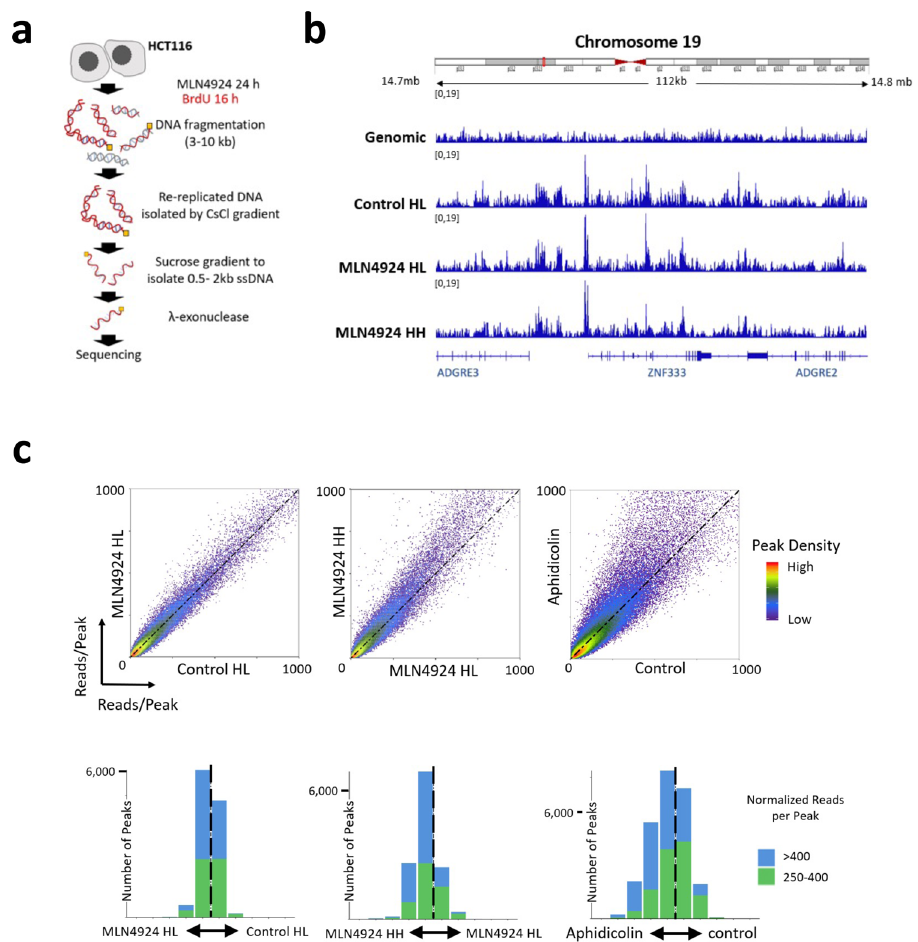
Fig. 3 Re-replication is driven by the same set of origins utilized during normal mitotic growth. a Schematic representation of the method used to map replication origins in re-replicating DNA. Cells were treated with MLN4924 for 24 h, including exposure to BrdU for 16 h. Genomic DNA was fragmented and re-replicated DNA (MLN HH DNA from cells incubated with BrdU for less than an entire doubling period) was isolated by BrdU-CsCl gradient. Normal replicated DNA (Control HL DNA and MLN HL DNA, only one DNA strand labeled with BrdU) was also collected to map normal replication origins as a control. Following the CsCl gradient, newly replicated nascent DNA was isolated from both normal- and re-replicated DNA using sucrose gradient and lambda exonuclease. DNA fragments that are resistant to λ -endonuclease digestion (RNA primed, yellow squares) are nascent strands 45 . b IGV screenshot showing representative nascent DNA outputs in genomic control, during normal mitotic replication (Control-HL and MLN-HL), and during re- replication (MLN4924-HH). c Density plots (top panel) comparing replication origin usage in 2 normal mitotic replication samples (Control-HL and MLN4924-HL, left) and in one normal and one re-replication samples (MLN4924-HL and MLN4924-HH, middle). The location of each data point is proportional to the number of reads per origins. Origins that initiate replication with similar frequency during normal mitotic growth and in re-replicating cells are located on the diagonal dotted line; for the middle panel, origins above the diagonal dotted line initiate more frequently in re-replicating cells and vice versa. The right panel used as positive control for dormant origin activation showing augmented origin activation in aphidicolin treated cells (0.8 µ M of Aphidicolin for 24 h). Reads per origin data of the above density plots were further divided into 10 fractions ranging from origins that showed the highest ratio of initiation frequency of y-axis sample (for example MLN4924 HH of the middle panel) vs. x-axis sample (for example MLN4924 HL of the middle panel) to origins that showed the highest ratio of initiation frequency of x-axis sample vs. y-axis sample). The number of peaks in each of the 10 fractions is shown as bar graphs (bottom panel) to show the cumulative distribution of small peaks with 250 – 400 reads (green) and large peaks >400 reads (blue). The vertical dash line in the middle equal to the diagonal dash line in the above density